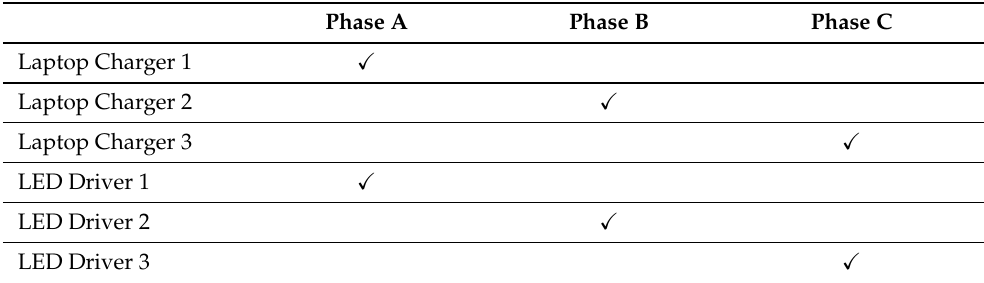
Table 2. Device configurations for AC Scenarios 3 and 4.